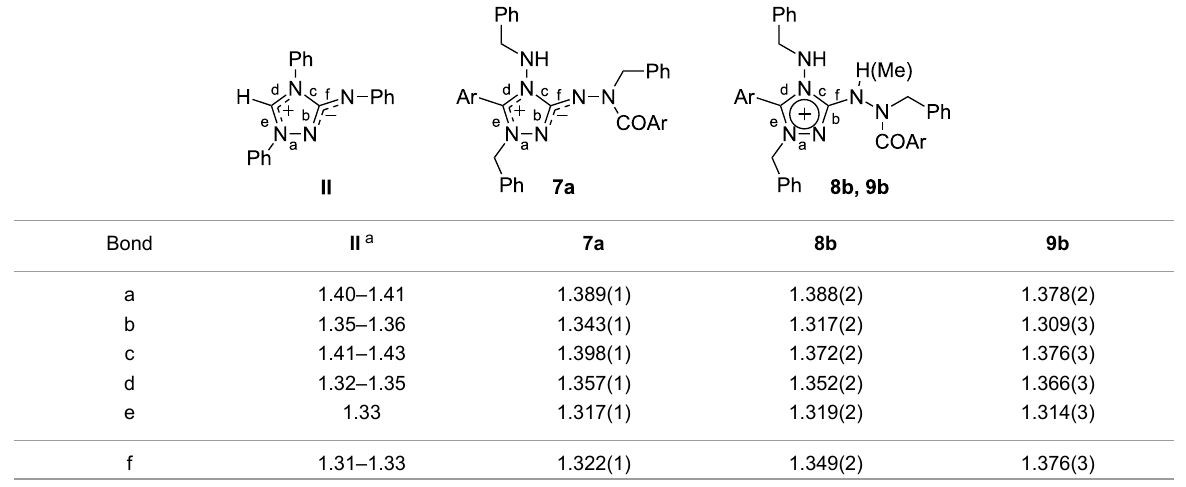
Table 2: Selected bond lengths (Å) in 1,2,4-triazolium-3-aminides II and 7a and 1,2,4-triazolium salts 8b and 9b